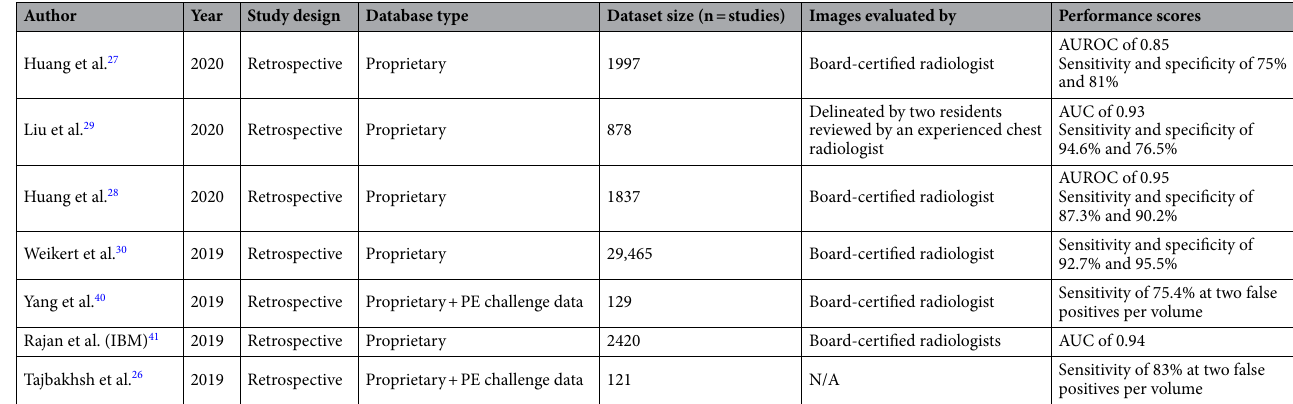
Table 1. A summary of the articles in the literature review that applied deep learning techniques for pulmonary embolism detection on computed tomographic pulmonary